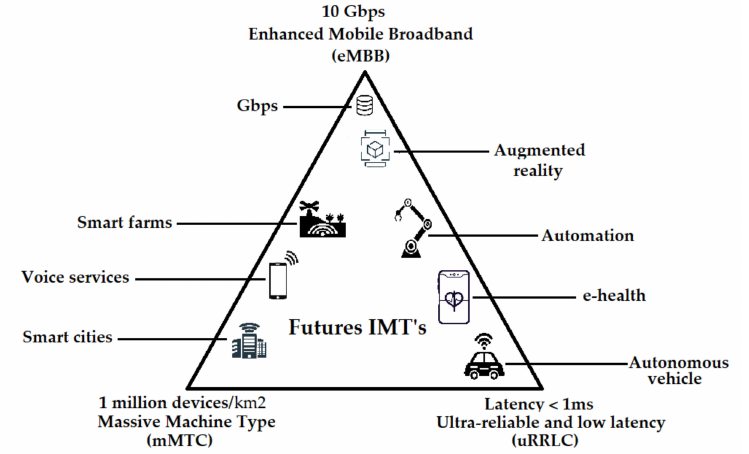
Figure 1. 5G Application Scenarios. Source: